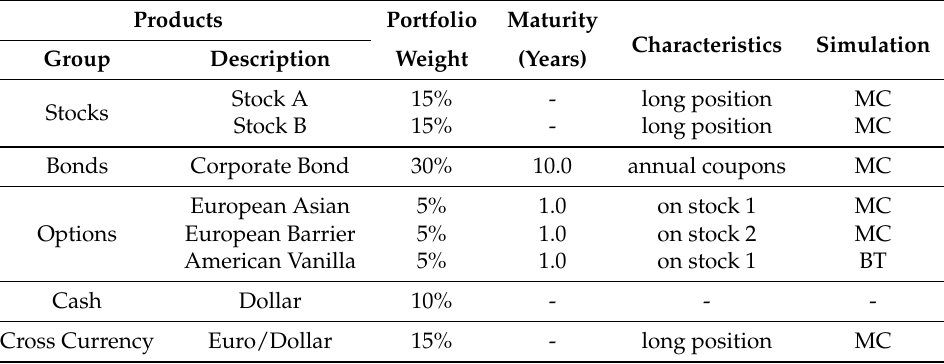
Table 1. Portfolio